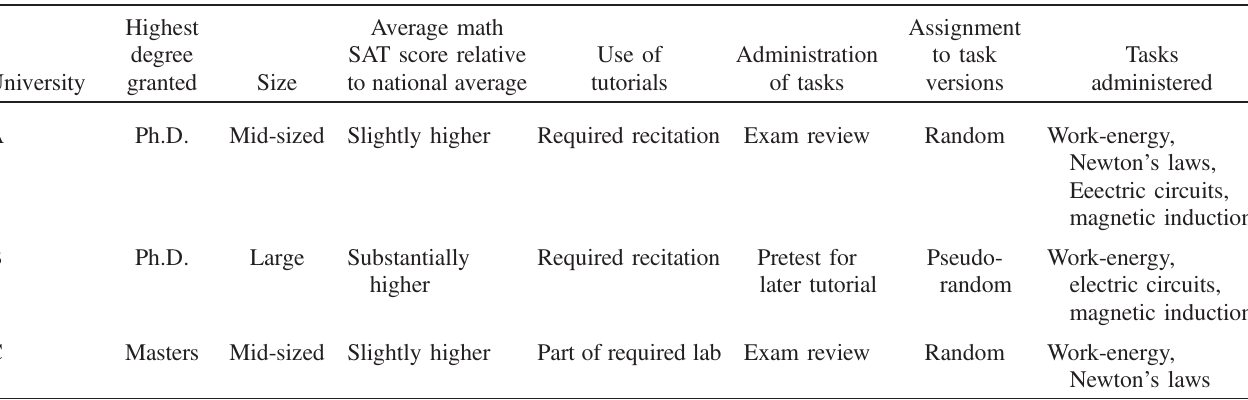
TABLE I. Key features and differences between the three universities where data were